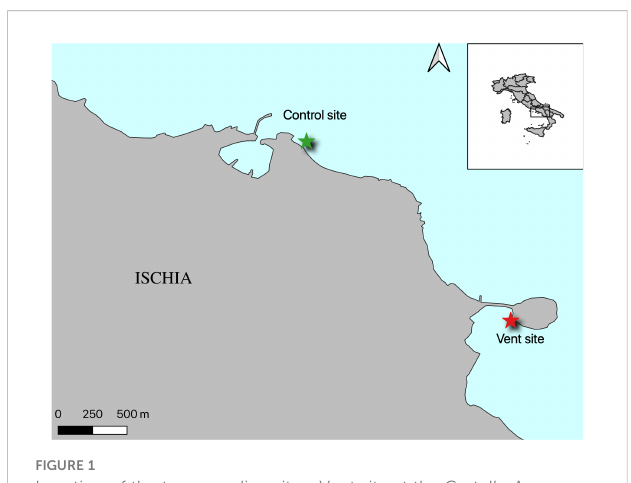
FIGURE 1 Location of the two sampling sites: Vent site at the Castello Aragonese (40°43 ’ 57.9 ” N - 13°57 ’ 51.8 ” E), Control site at San Pietro Point (40° 44 ’ 47.6 ’’ N; 13°56 ’ 40.42 ’’